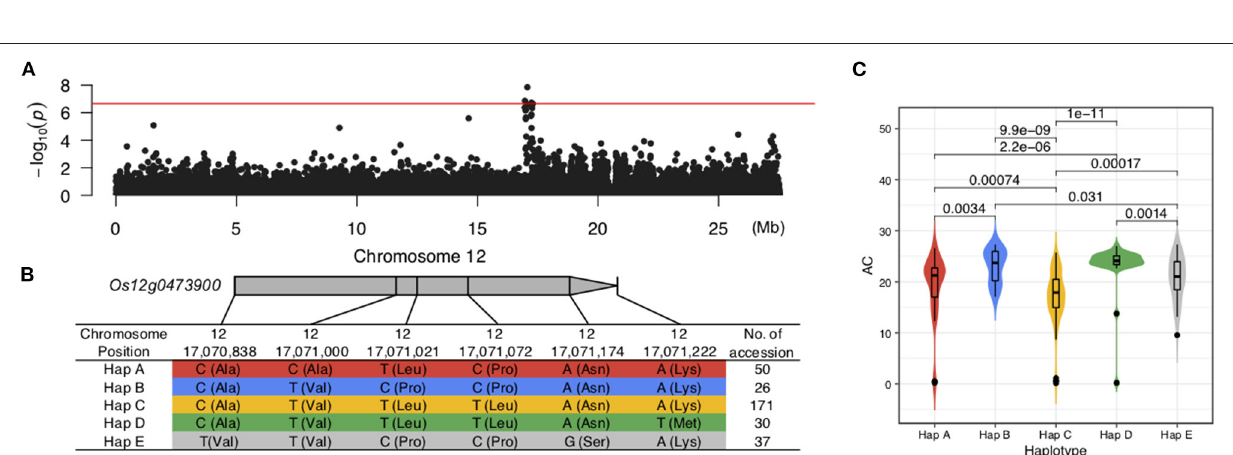
TABLE 2 | Candidate genes located in the local LD block of qLWR7-2.